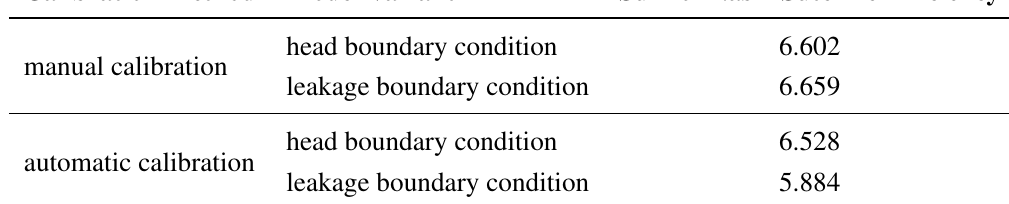
Table 5. Sum of Nash–Sutcliffe efficiencies over observation points U01 to U07 from Table